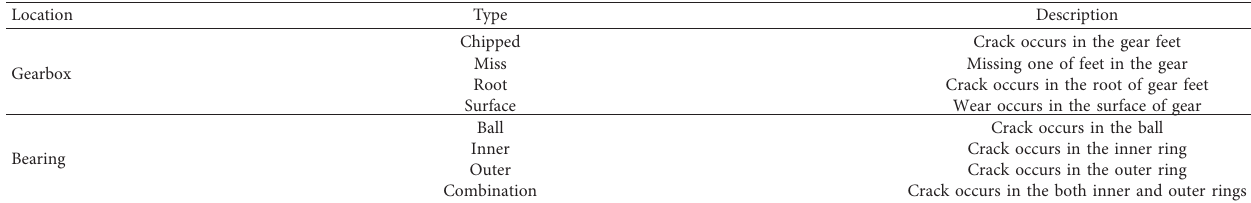
Figure 7: Experimental setup for gearbox dataset [34]. Table 1: Bearing and gearbox fault types